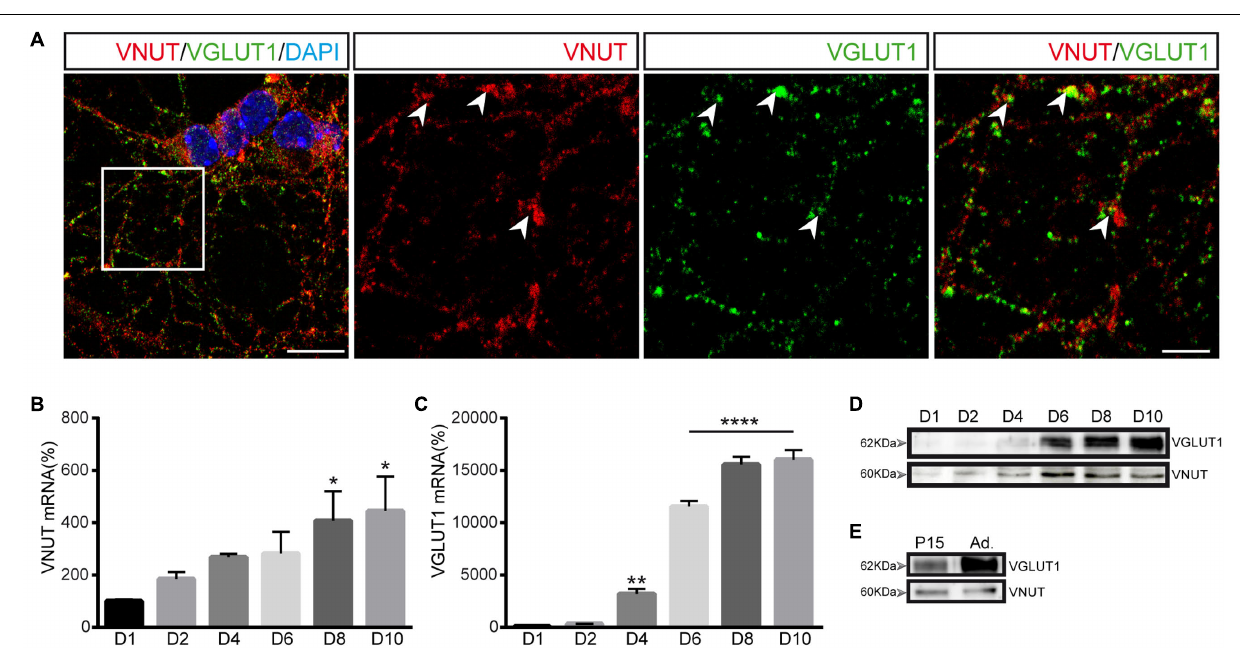
FIGURE 5 | Expression of VNUT and VGLUT1 in cerebellar granule cells. (A) Representative confocal images showing double immunofluorescence for VNUT (red) and VGLUT1 (green). The nuclei were counterstained with DAPI (blue). Scale bar: 12 µ m. Right panels represent a higher magnification to show the immunostaining for each vesicular transporter. The arrowheads indicate co-localization of the immunoreactivity for VNUT and VGLUT1. Immunofluorescence was performed on day 7 in vitro . Scale bar: 5 µ m. VNUT (B) and VGLUT1 (C) mRNA levels analyzed by qPCR of cerebellar granule cells after different days of the culture. The values represent the mean ± SEM ( n = 3: ∗ p < 0.05, ∗∗ p < 0.01, ∗∗∗ p < 0.001, ANOVA with Dunnet test with respect to day 1). (D) Western blots of the total protein (10 µ g) in cell lysates after different times in culture. (E) Western blot of total protein extracts from cerebellum used as positive control of VNUT and VGLUT1